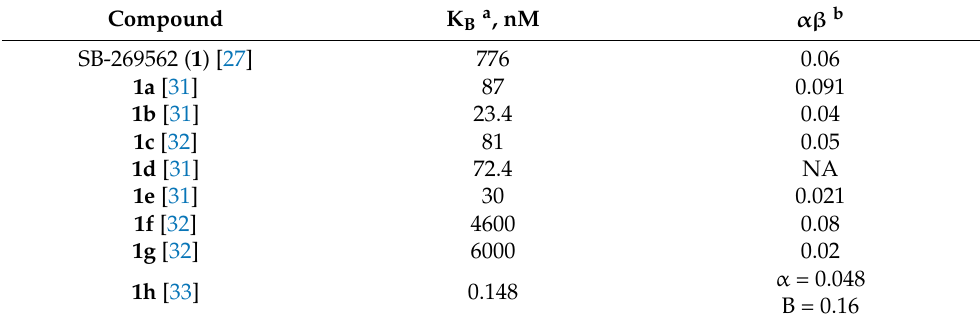
Table 1. Allosteric parameters of SB269562 and its analogues. NA—not available. a Estimate of the equilibrium dissociation constant determined in a pERK1/2 functional assay; b Estimate of the net cooperativity factor between the modulator and determined in an pERK1/2 functional